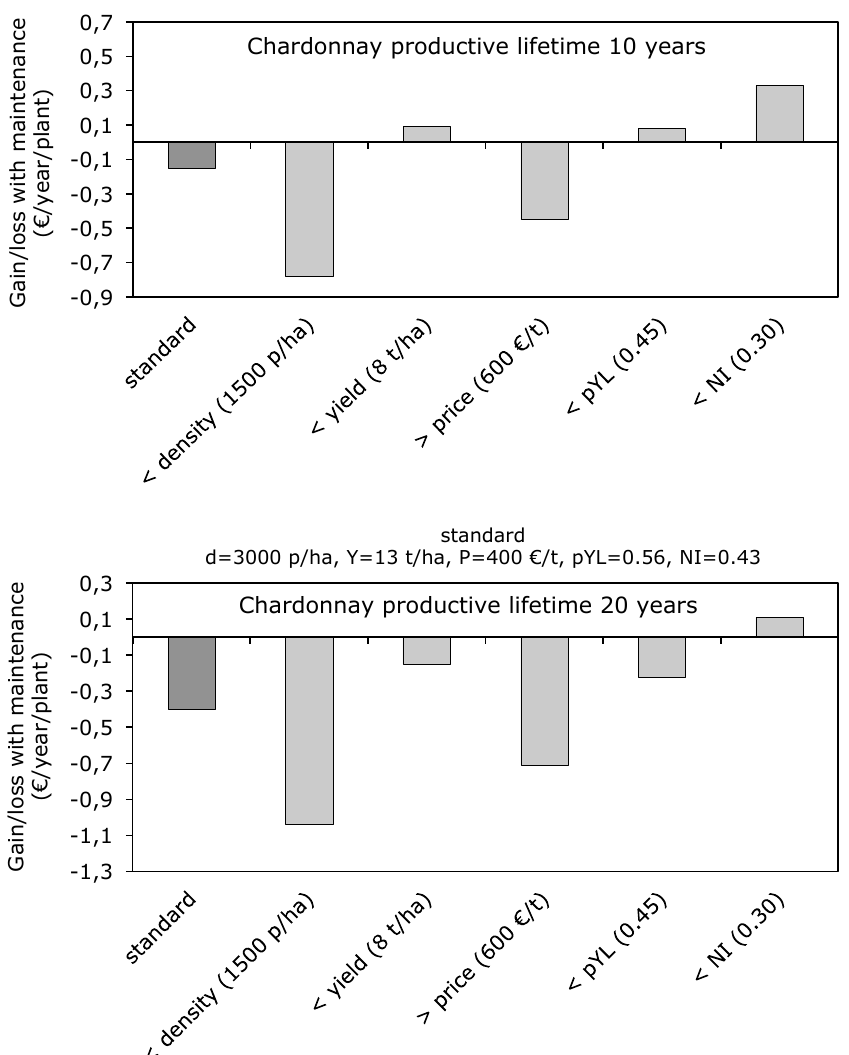
Figure 2. Average gain or loss per year per plant for maintenance in comparison to replacement for ‘Chardonnay’ infected by FD, assuming productive lifetimes of 10 and 20 years. The gain or loss obtained at standard conditions is compared with that obtained by increasing (>) or decreasing (<) some